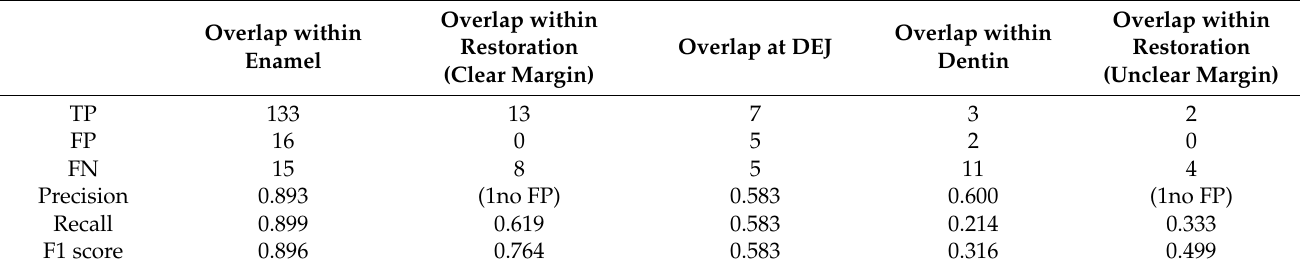
Table 2. Precision, recall, and F1 score per class.